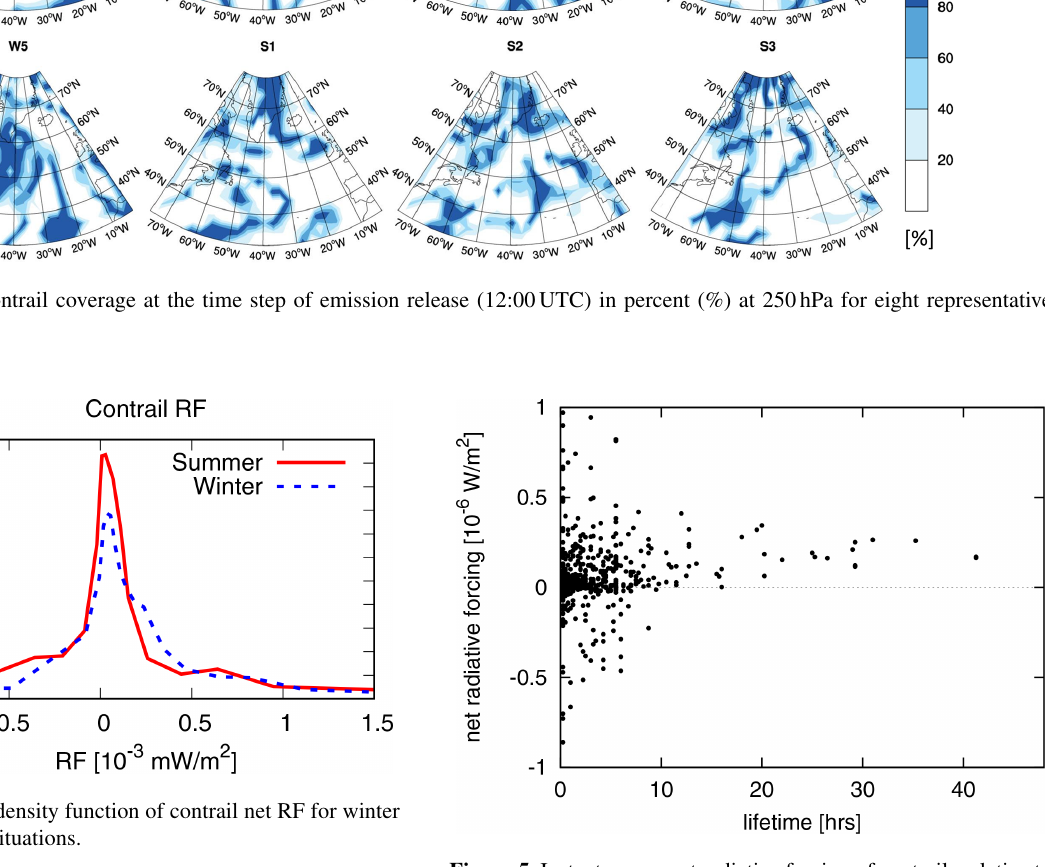
Figure 5. Instantaneous net radiative forcing of contrails relative to the contrail lifetime for winter and summer weather